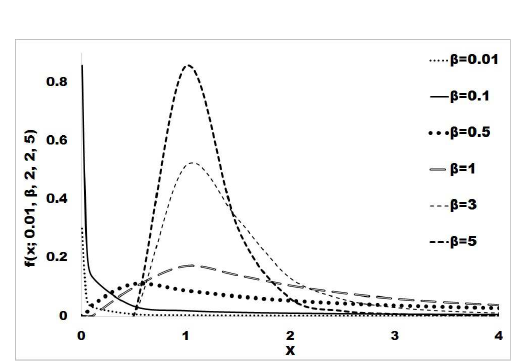
Figure 1 – Plots of pdf of EKIWD ( α, β, ρ, σ, δ ) for particular values of its parameters.